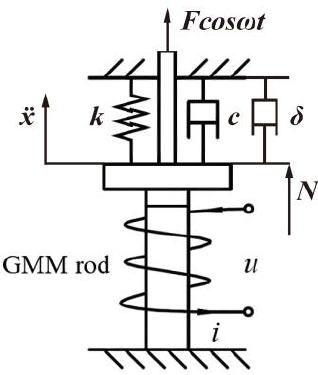
Figure 6. Simplified model of GMA fractional damping system.